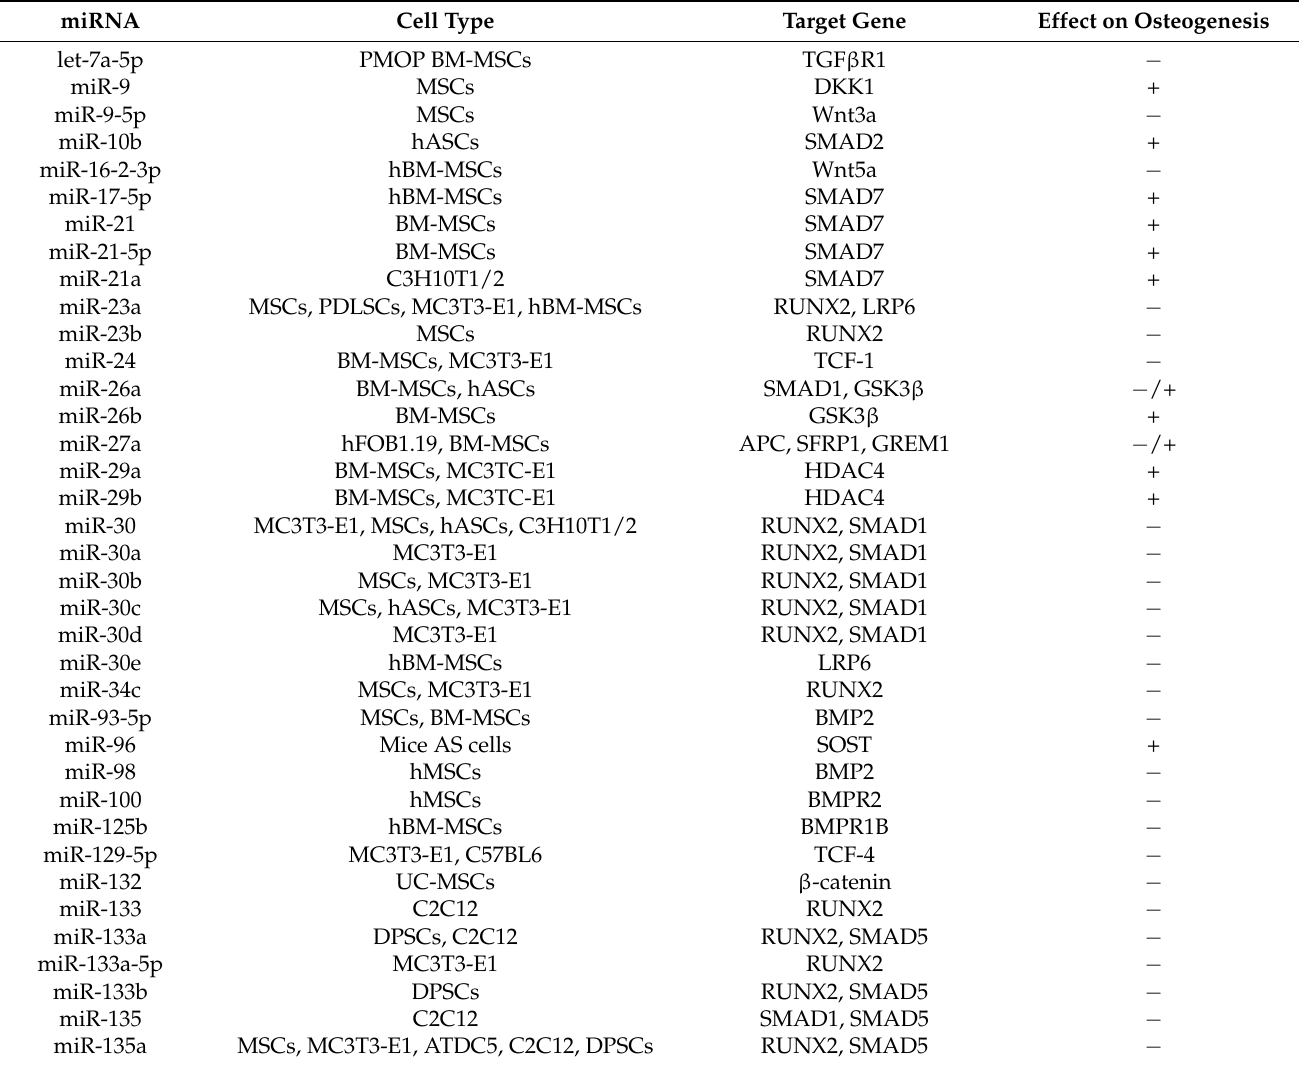
Table 1. MicroRNAs, their direct target genes and cell types in which they play a role during osteogenesis. miRNA Cell Type Target